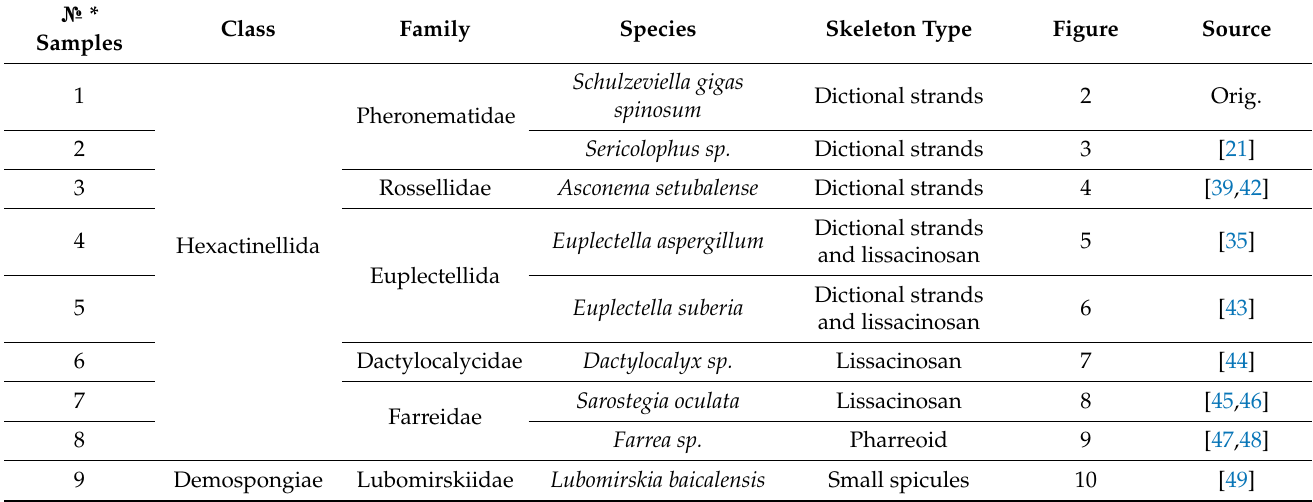
Table 1. Samples of the investigated